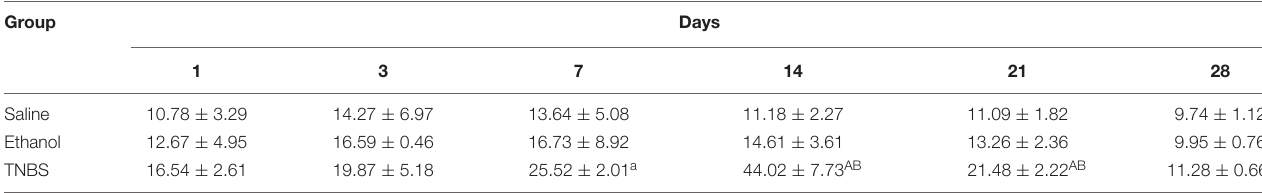
TABLE 1 | Effects of TNBS administration on CGRP-immunoreactivities expression in DRG of rats.